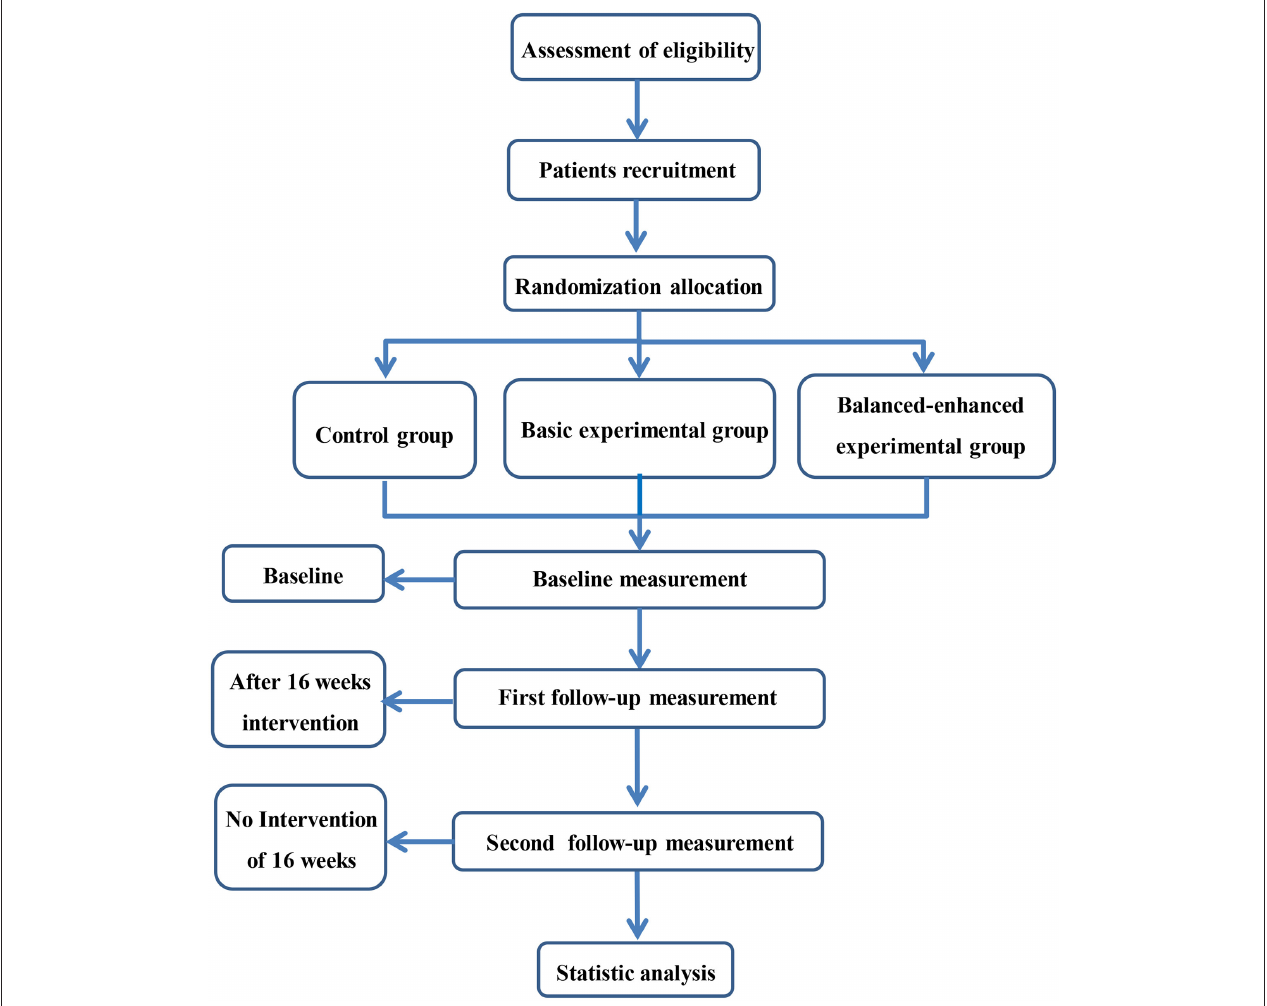
FIGURE 1 | Trail flow